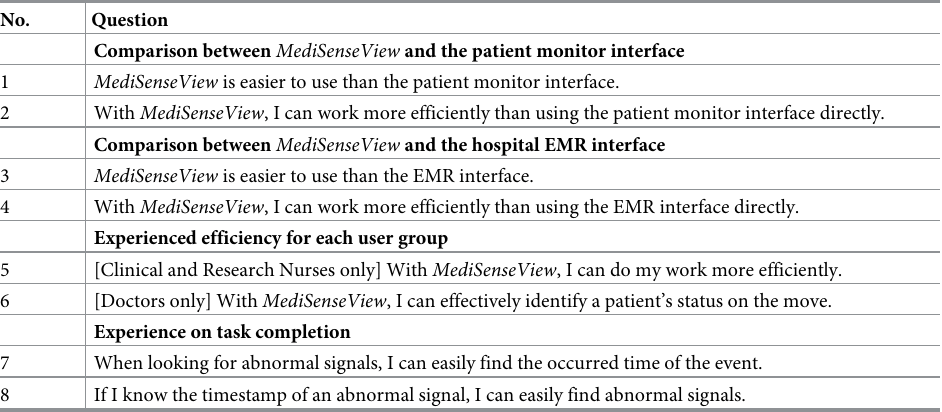
Table 4. Questions used in the post-survey. Answers were provided in 7-point Likert scale.